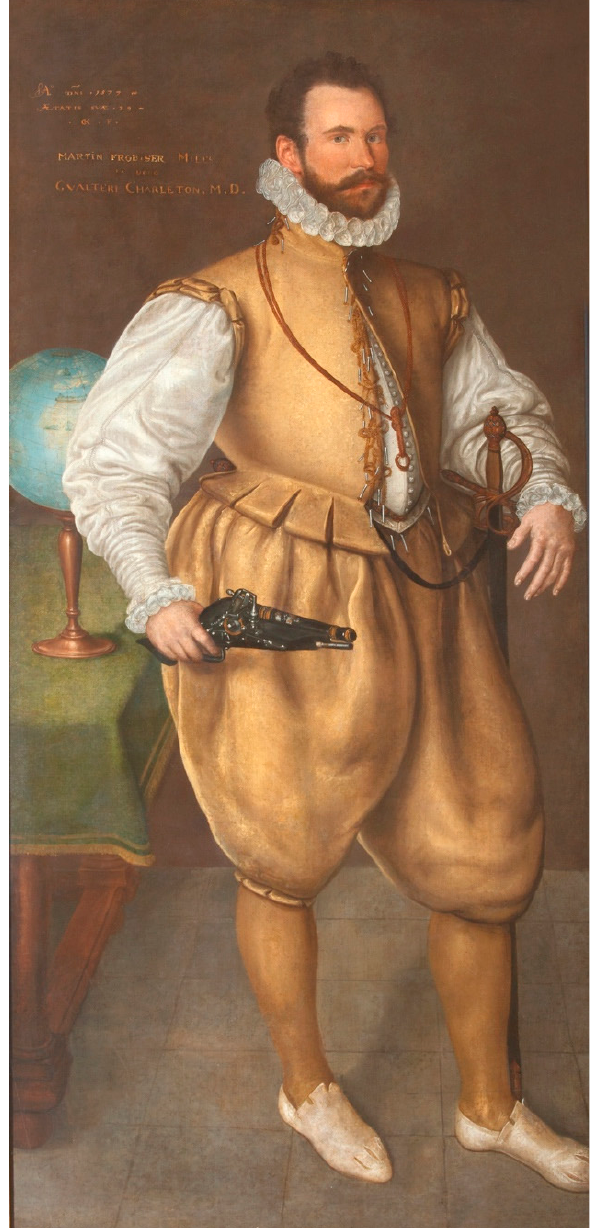
Figure 7. Cornelis Ketel, Portrait of Sir Martin Frobisher (1535?–1594) Bodleian Library LP 50. Copyright holder Photo: © Bodleian Libraries, University of Oxford, UK. Creative Commons licence CC-BY-NC 4.0.